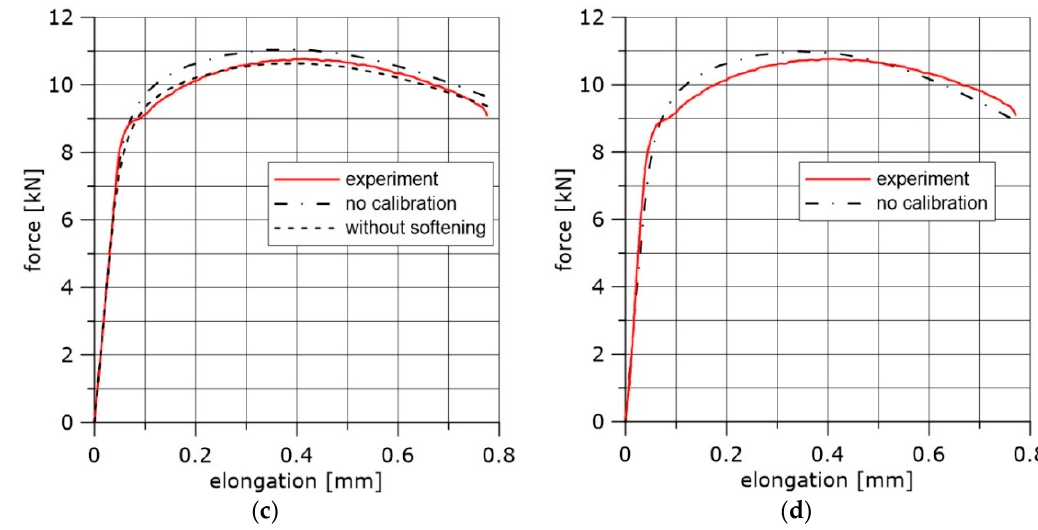
Figure 4. The force–elongation curves obtained before and after calibration of the true stress–logarithmic strain curves, ( a ) Material NW, temperature +20 °C, specimen used for calibration: R1. ( b ) Material HW, temperature +20 °C, specimen used for calibration: PN. ( c ) Material N, temperature − 50 °C, specimen used for calibration: R04, linear approximation. ( d ) Material N, temperature − 50 °C, specimen used for calibration: R04, power function approximation.